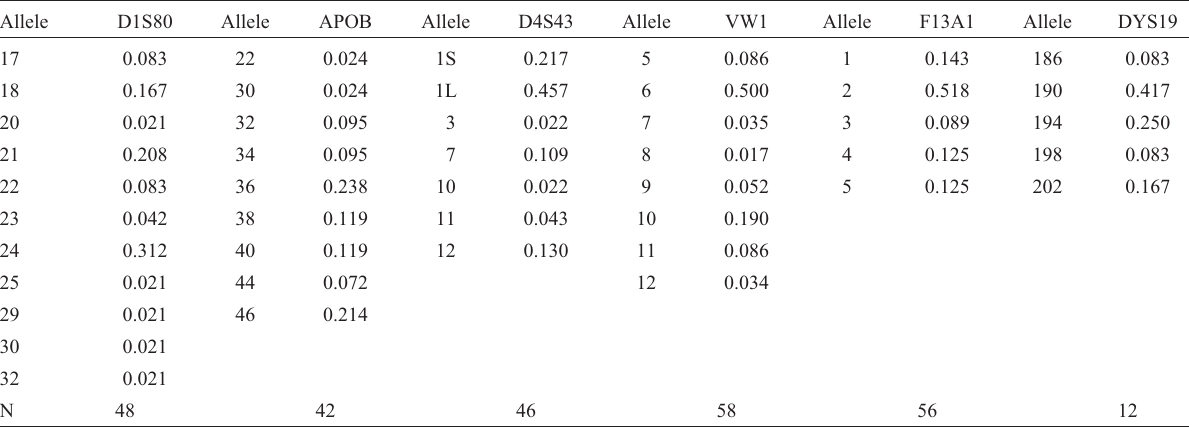
Table 1 - Allele frequency distribution for six hypervariable loci in the Pacoval population. Allele Allele